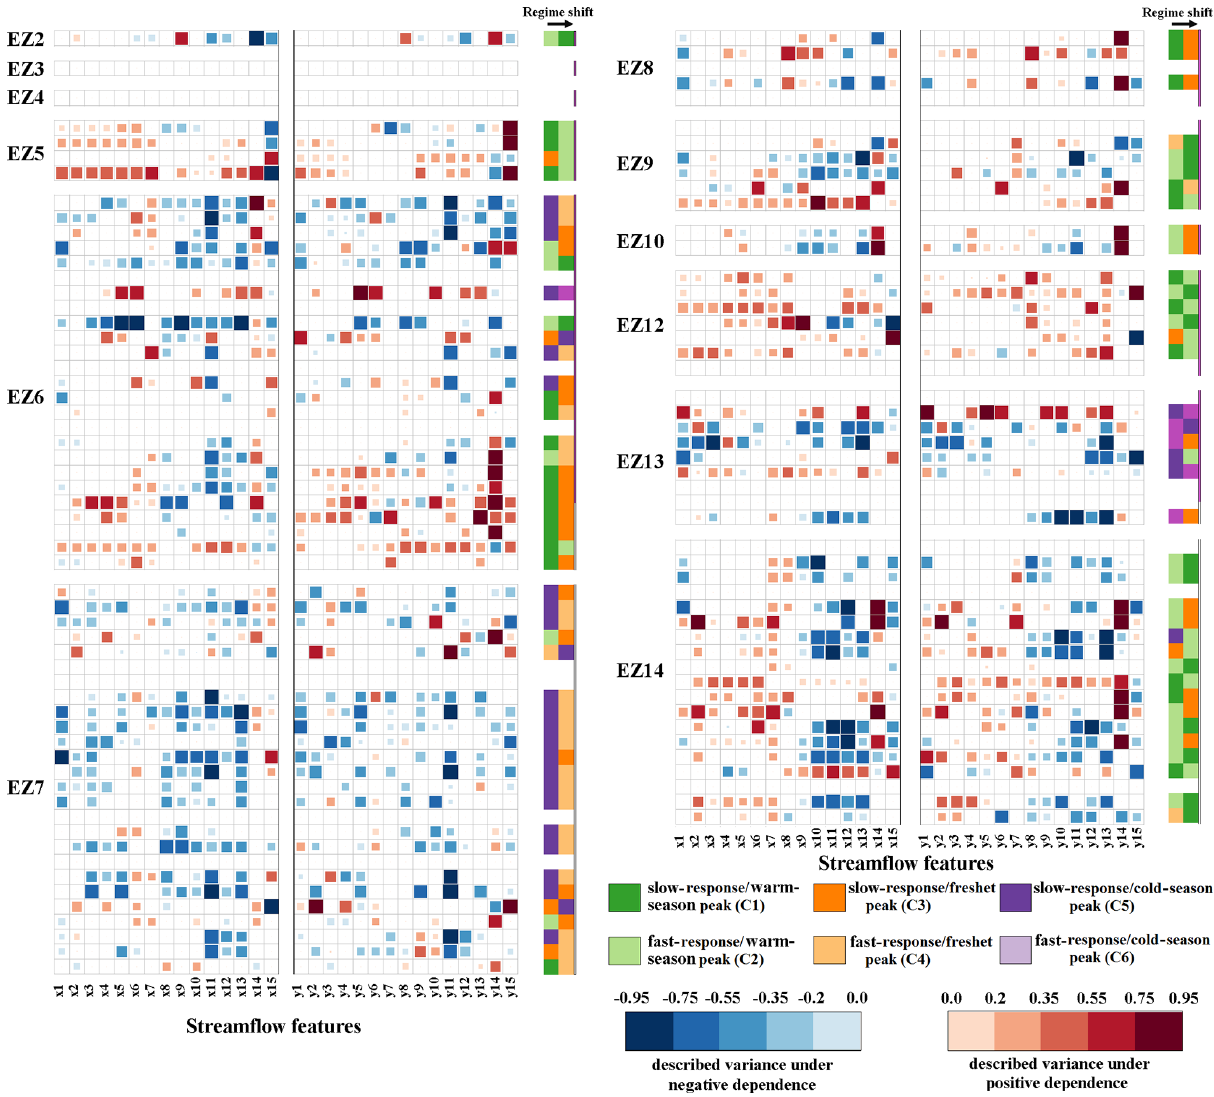
Figure 9. Dominant regime shifts across 105 RHBN streams in Canada attributed to the first and second moments of the 15 IHAs considered. Shades of red and blue show the positive and negative dependencies between changes in streamflow features and degrees of membership. Colour saturations are proportional to the values of the coefficient of determination. The dominant regime shift at each stream is identified by the colour scheme described in the legend. Streams are grouped in ecozones and ordered from low (top) to high (bottom)